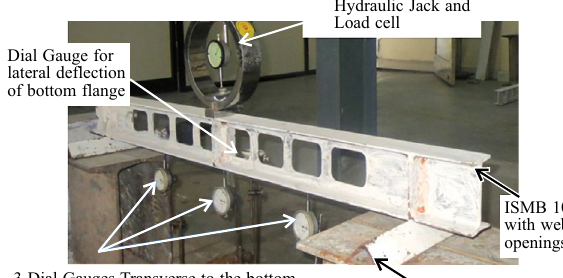
3 Dial Gauges Transverse to the bottom flange for vertical deflection Steel angles and rods for